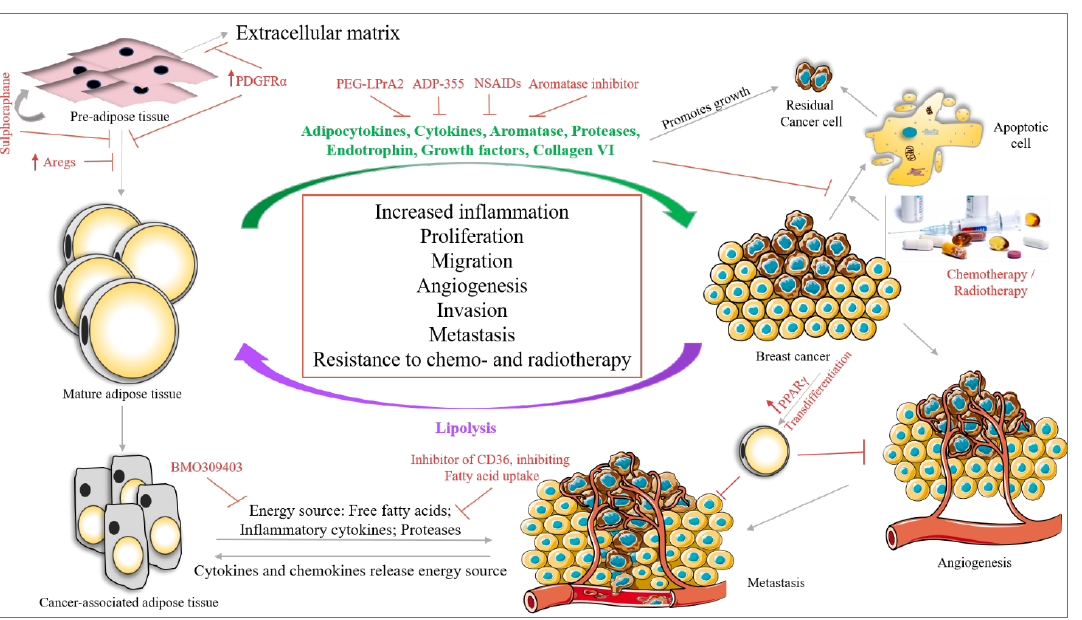
Figure 4. Interaction between BC cells and adipose tissue in the BC microenvironment. Breast adipose tissue secretes various molecules (green) which increase BC survival, proliferation, migration, angiogenesis and metastasis. These secretomes also help BC cells in evading chemotherapy mediated apoptosis and increase the survival of residual cancer cells after chemotherapy. BC cells also secrete cytokines and chemokines which signal lipolysis of adipose tissue, changing the secretory phenotype of adipose tissue to a cancer-associated phenotype. The cancer associated adipose tissue aids in BC survival by releasing inflammatory cytokines, proteases and providing the energy source in the form of free fatty acids. Studies have identified various approaches to target the crosstalk between BC cells and adipose tissue (indicated in red). By targeting the differentiation of pre-adipose tissue to mature adipose tissue, which can be performed by overexpressing adipogenesis regulatory cells (Aregs stop this differentiation), PDGFRα (changes the fate of pre-adipose tissue to extracellular matrix) or by treatment with Sulforaphane (which stimulates the regeneration of pre-adipocytes and inhibits its differentiation to mature adipocytes). Furthermore, the inhibition of fatty acid transporter 4 (BMO309403) inhibits the transfer of energy from adipose tissue to BC cells. Moreover, the inhibition of CD36 by monoclonal antibody against CD36 leads to the inhibition of fatty acid uptake by BC cells. Another study showed that increasing the expression of PPAR γ in BC cells could lead to trans di ff erentiation of BC cells into adipose tissue, thereby inhibiting BC